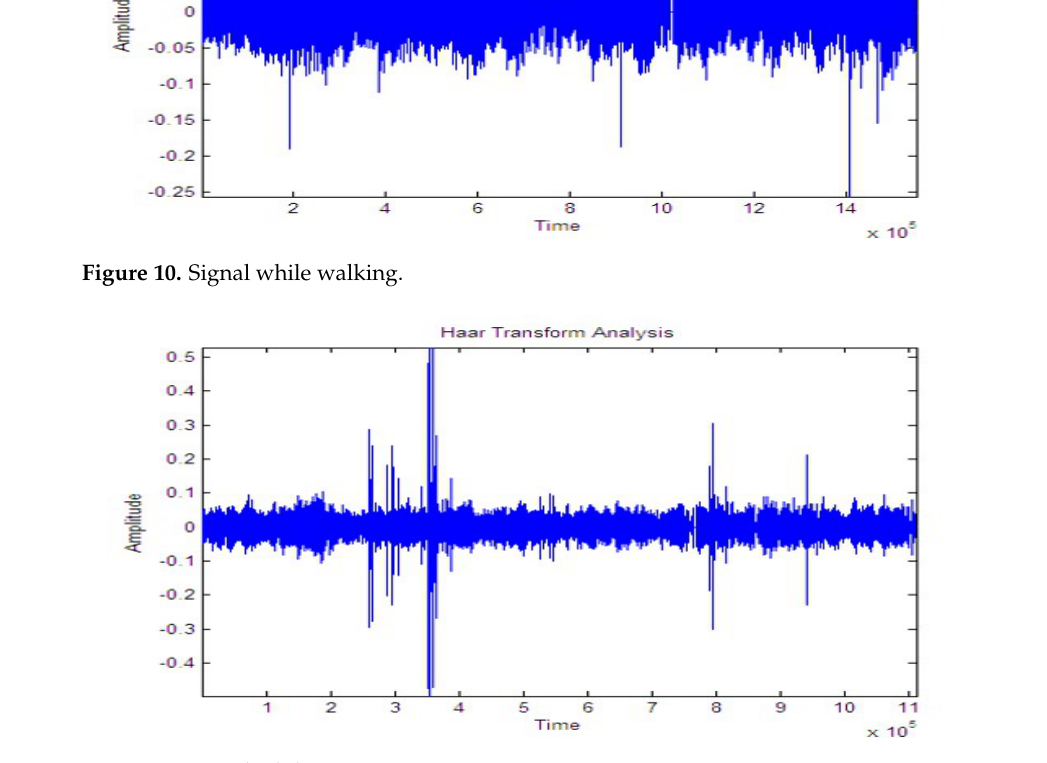
Figure 11. Signal while running.